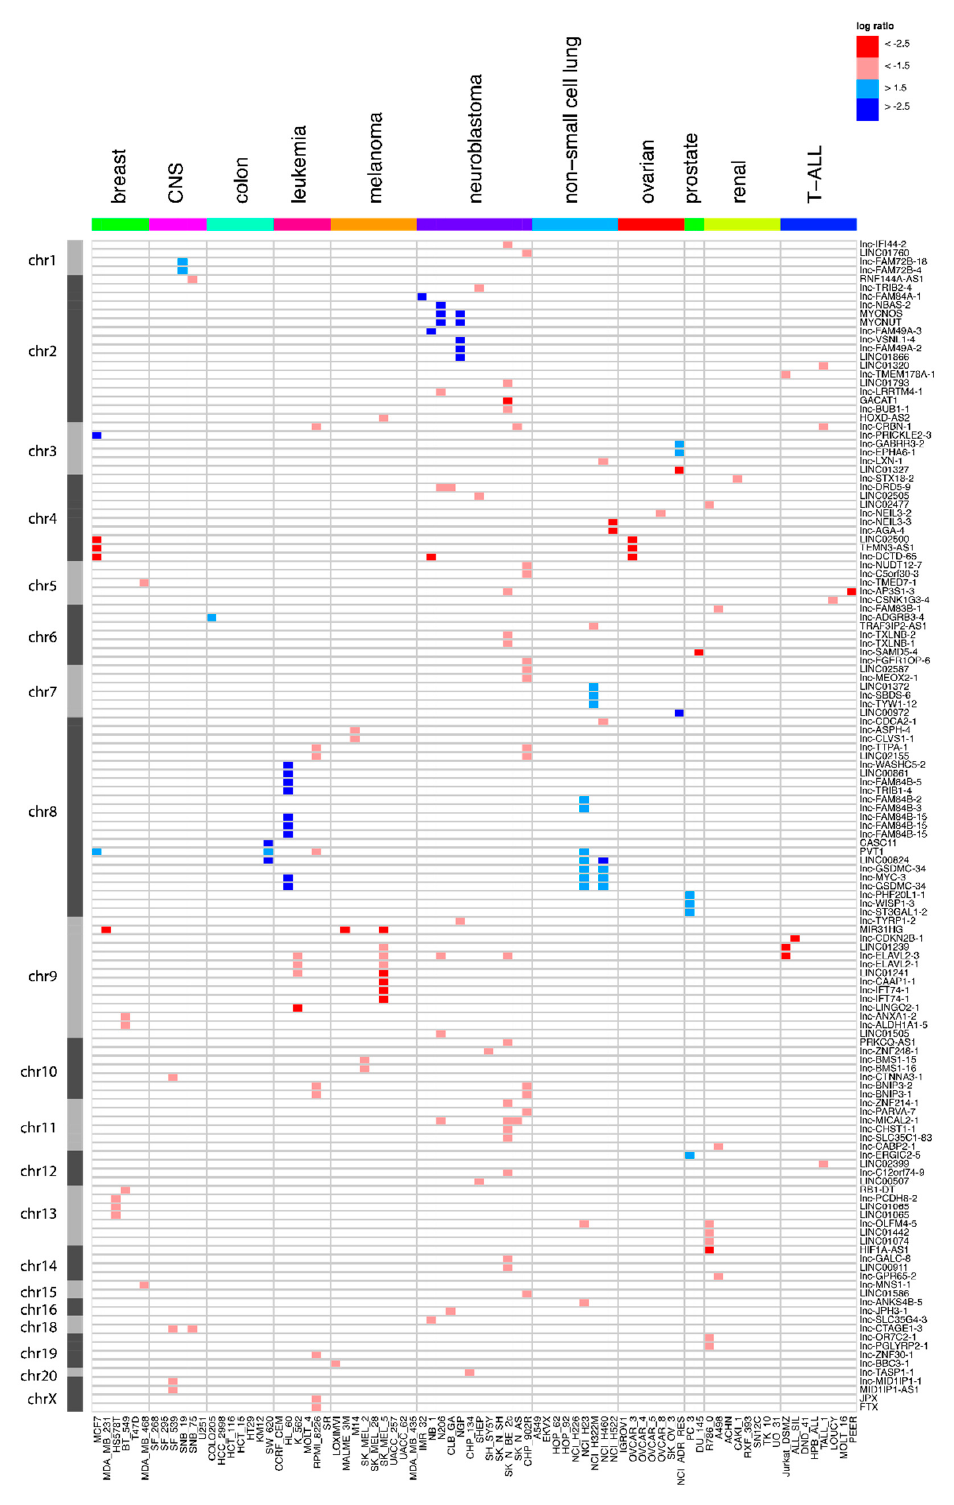
Figure 1. Overview of the long non-coding RNA (lncRNA) genes affected by focal somatic copy-number alterations (SCNAs) after extensive filtering. Red represents the copy number loss (log-ratio < 1.5) in that cell line, while blue corresponds to copy number gain (log-ratio > 1.5). Dark red and blue correspond to copy number changes with absolute log-ratios of above